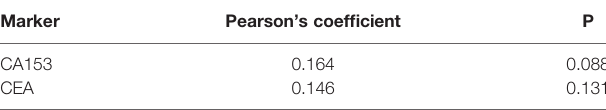
TABLE 4 | Pearson association analysis of serum levels of FEN1, CA153, and CEA.